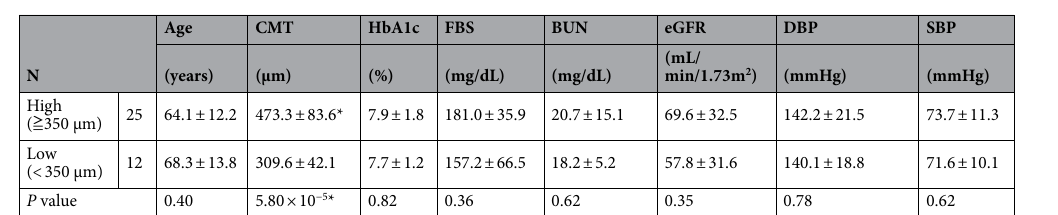
Table 2. Demographics of the DME patients. BUN: blood urea nitrogen, CMT: central subfoveal macular thickness, DBP: diastolic blood pressure, eGFR: estimated glomerular filtration rate, FBS: fasting blood sugar, HbA1c: hemoglobin A1c, SBP: systolic blood